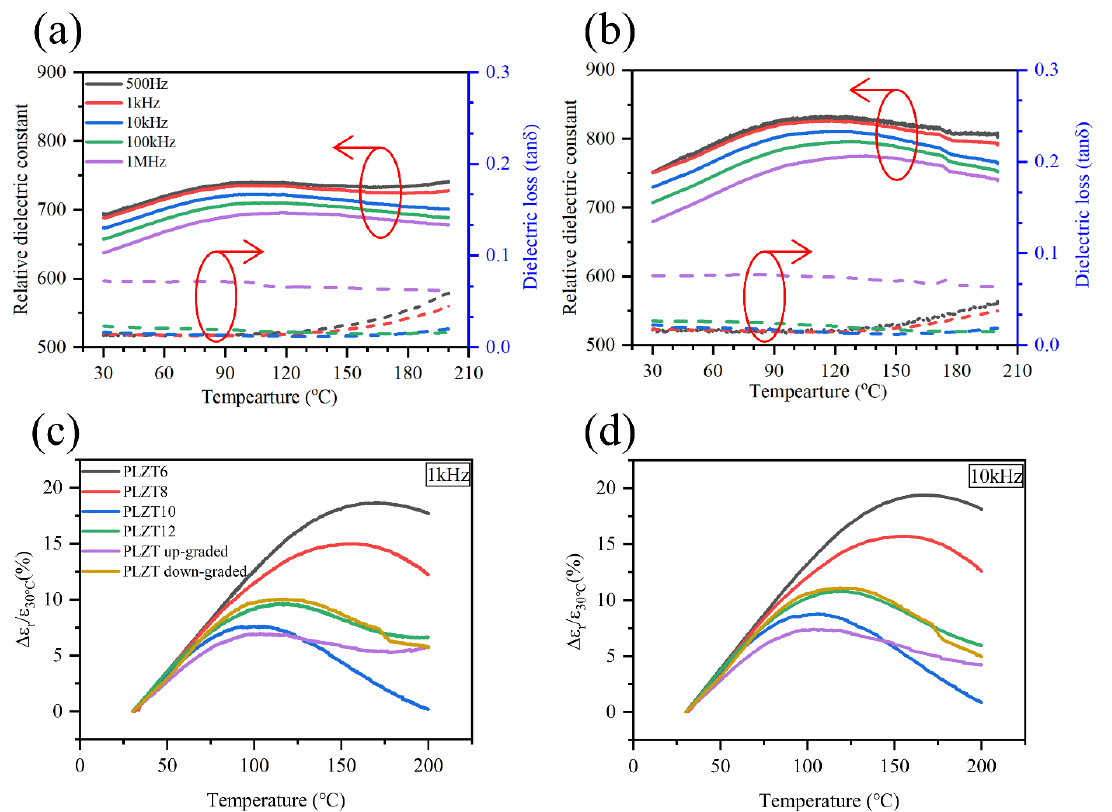
Figure 4. Temperature dependent dielectric constant of the ( a ) up-graded and ( b ) down-graded PLZT thin films. ( c ) Temperature stability of the PLZT thin film when measured at ( c ) 1 kHz and ( d ) 10 kHz.